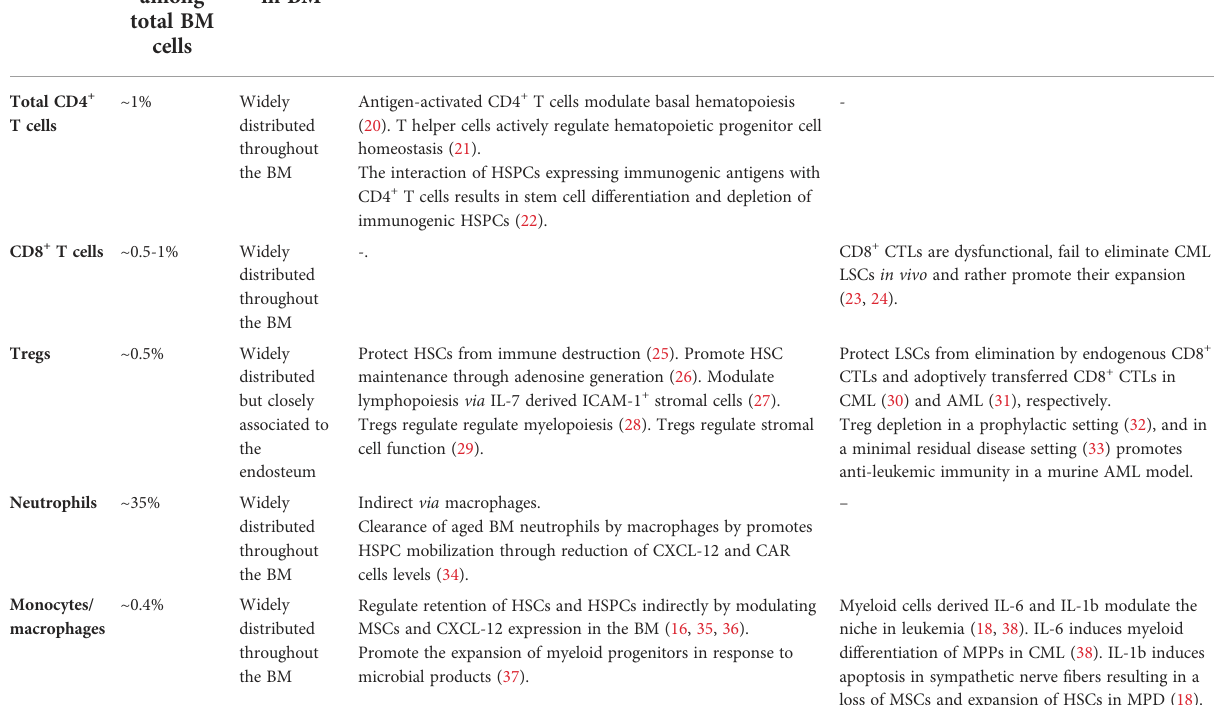
TABLE 1 Immune cell subsets present in the BM stem cell niche and their reported effect on the HSCs and HSC niche function. Cell Type Frequency Location among in total BM cells